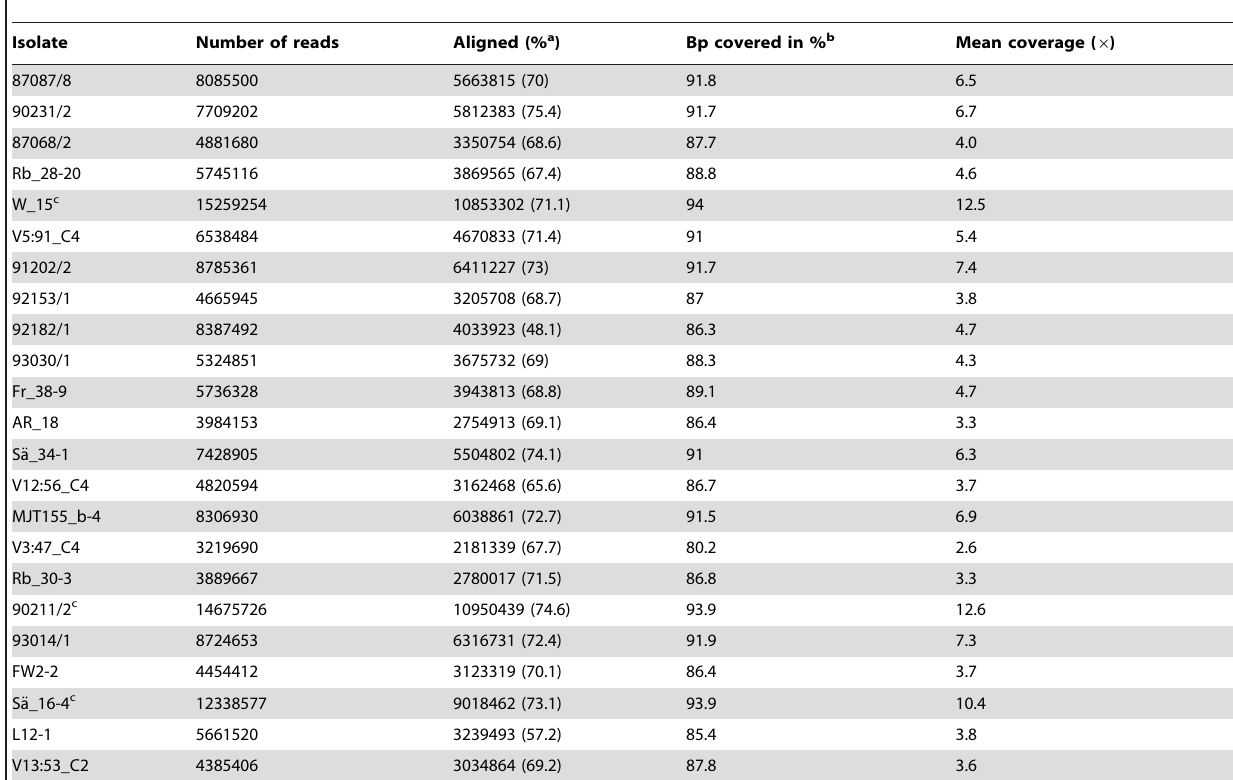
Table 1. Sequence data for the fungal isolates.